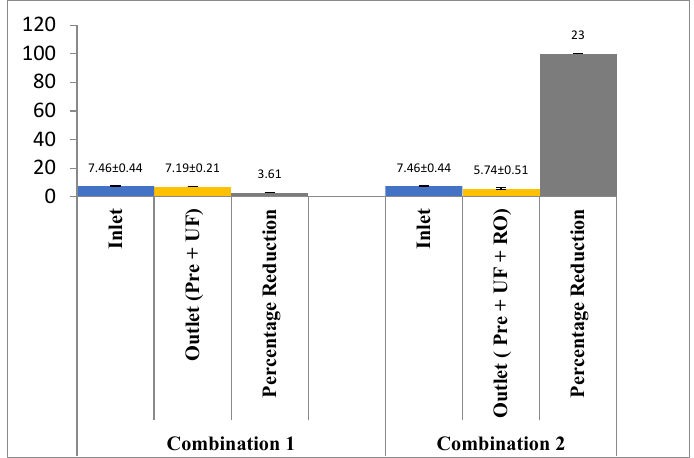
Figure 3. Effect of different treatment setups on the pH rejection .